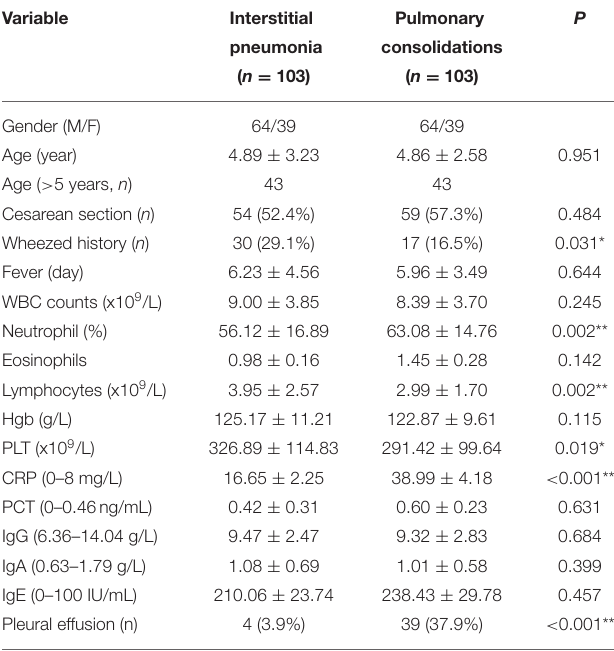
TABLE 3 | Differences in clinical characteristics between IP and PC after propensity score analysis (PSA). Variable Interstitial Pulmonary